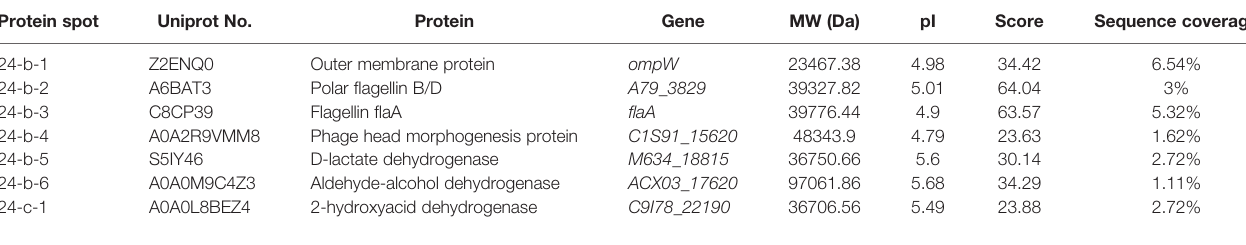
TABLE 2 | Identi fi cation of the protein spots on the secretome pro fi les by LC-MS/MS analysis. Protein spot Uniprot